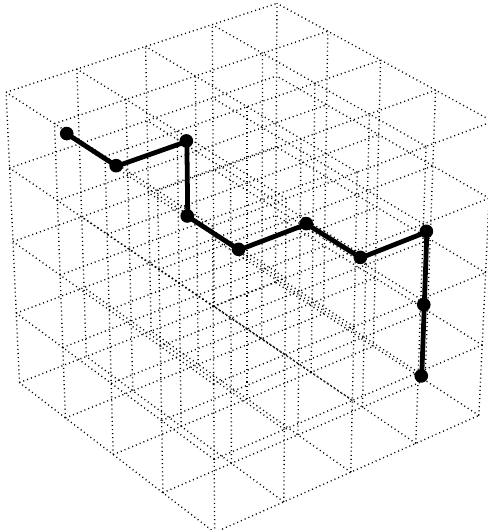
Figure 2. Visual representation of Equation (4) showing a three-dimensional lattice of a polymer solution mixture. N 0 , total number of lattice sites (all cubes): N s , number of solvent molecules (empty cubes); and N p r , number of polymer repeat units (cubes with black dots connected with black lines)